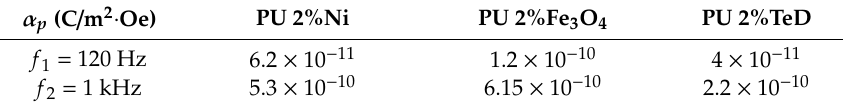
Table 1. Magnetoelectric coe ffi cient values of polyurethane based composite films [76].